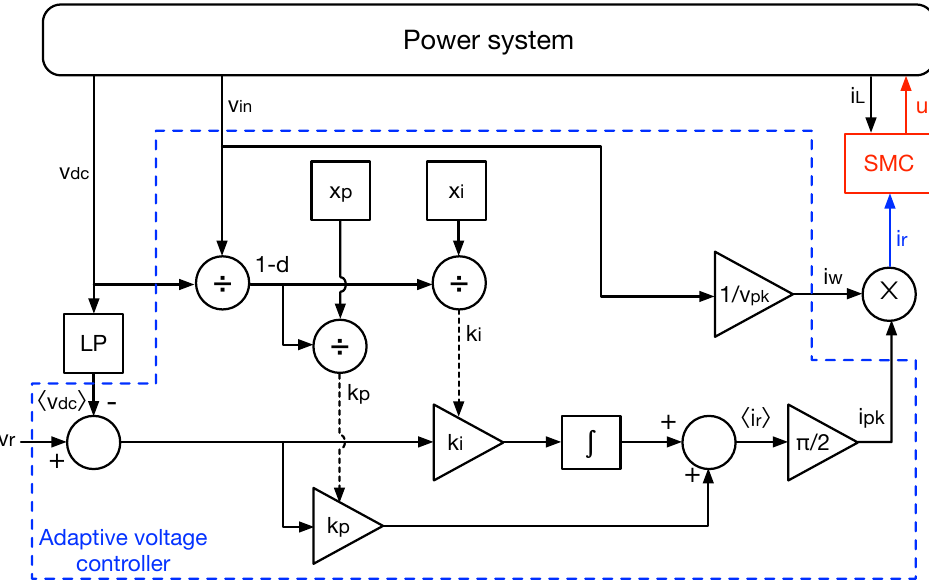
Figure 6. Structure of the adaptive voltage